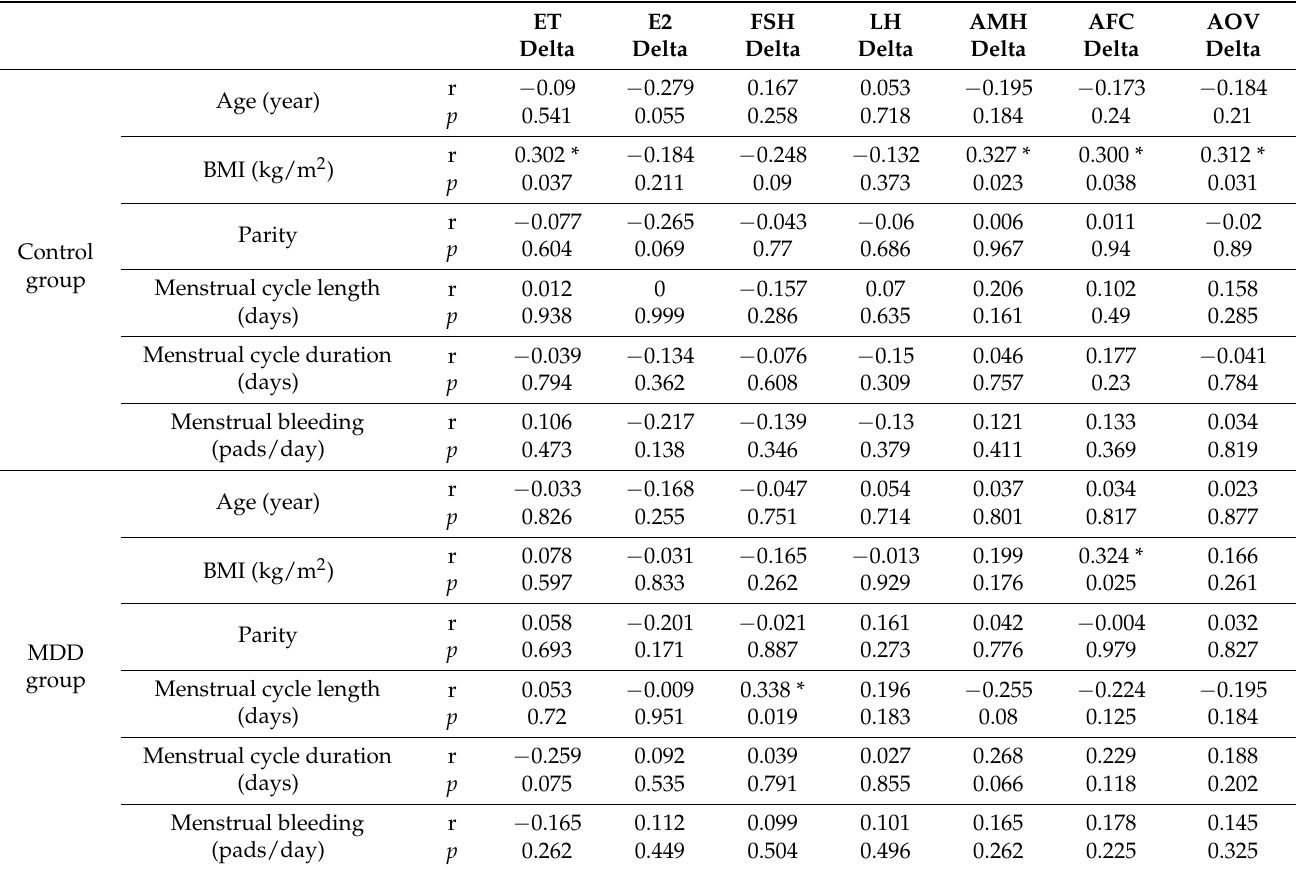
Table 3. Relationships among examined parameters.